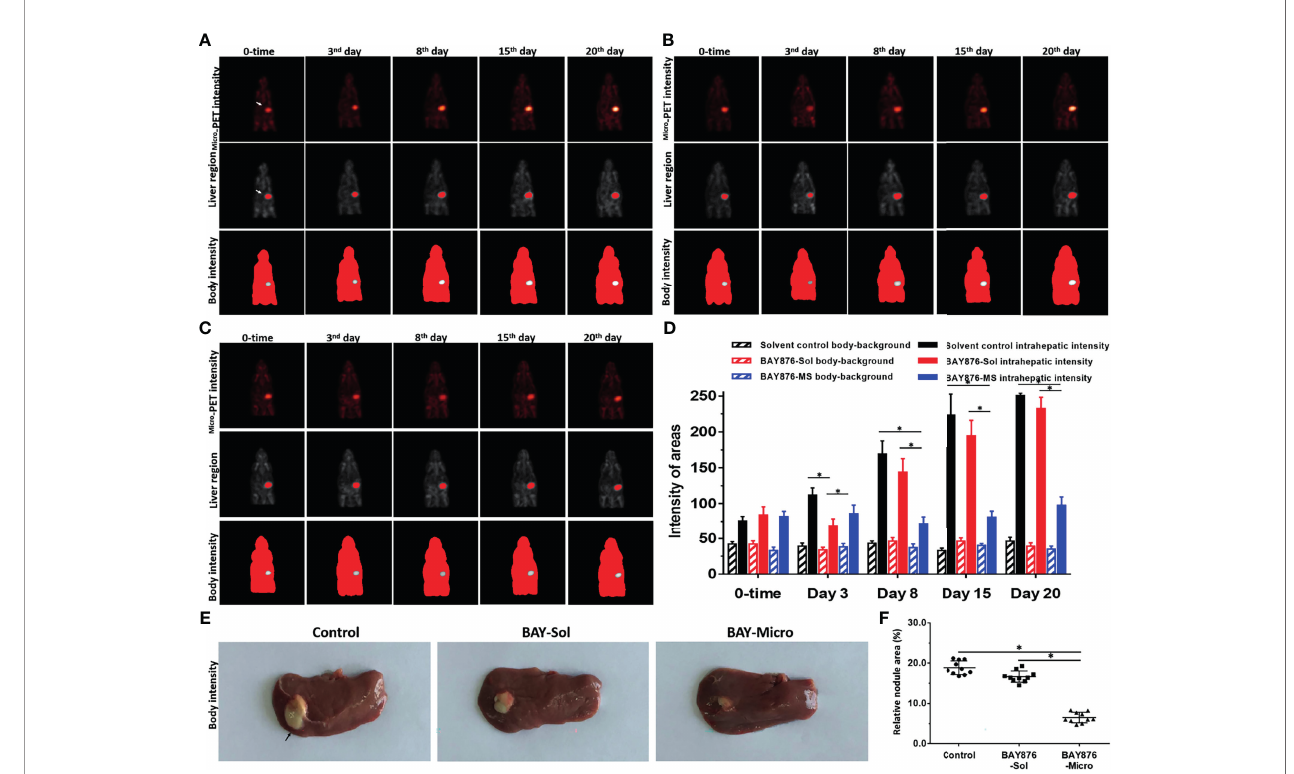
FIGURE 6 | Effects of long-acting anti-tumor microcrystalline BAY-876 formulation on the intrahepatic of MHCC97-H cell tumor model. MHCC97-H cells were cultured to generate intrahepatic tumor lesions in the immunode fi cient rat. (A) Solvent control, (B) BAY-Sol (BAY-876 solution), and (C) BAY-Micro (Bay-876 microcrystalline) formulations were directly injected into the subcutaneous tumor tissues. (A-C) The rats were analyzed using microPET over a series time points. The results are shown as representative microPET images. (D) The quantitative results of the images. (E) Images of the liver organs with tumor lesions, and (F) quantitative results of the images.